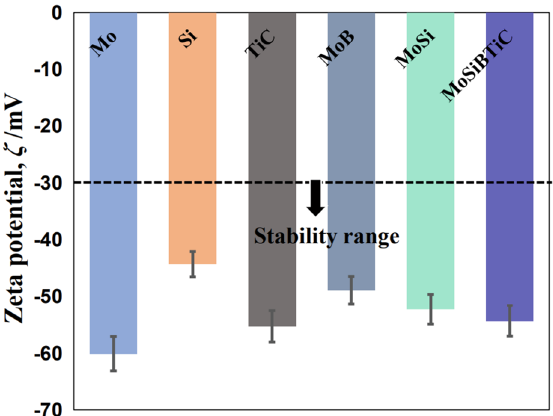
Figure 4. The zeta potential of various powders dispersed in water.